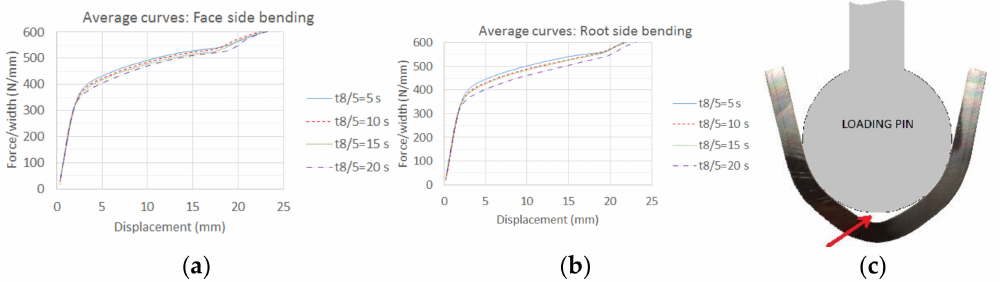
Figure 9. Average displacement-load/width curves for each heat input: ( a ) face side bending; ( b ) root side bending; ( c ) formation of the gap during testing induces the change in slope of the curve.